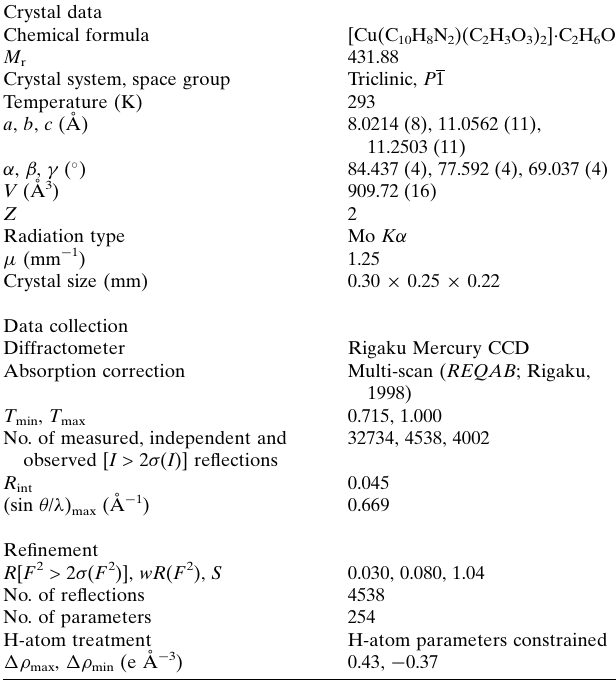
Table 3 Experimental details. Crystal data Chemical